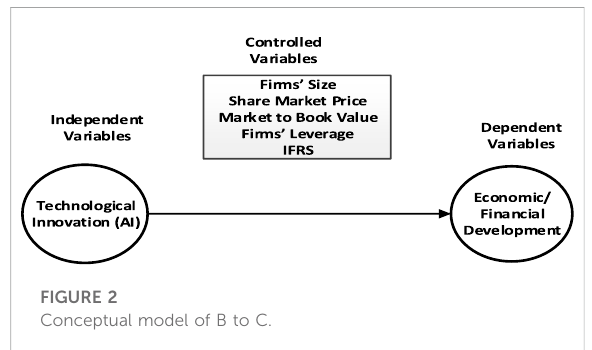
FIGURE 2 Conceptual model of B to C.